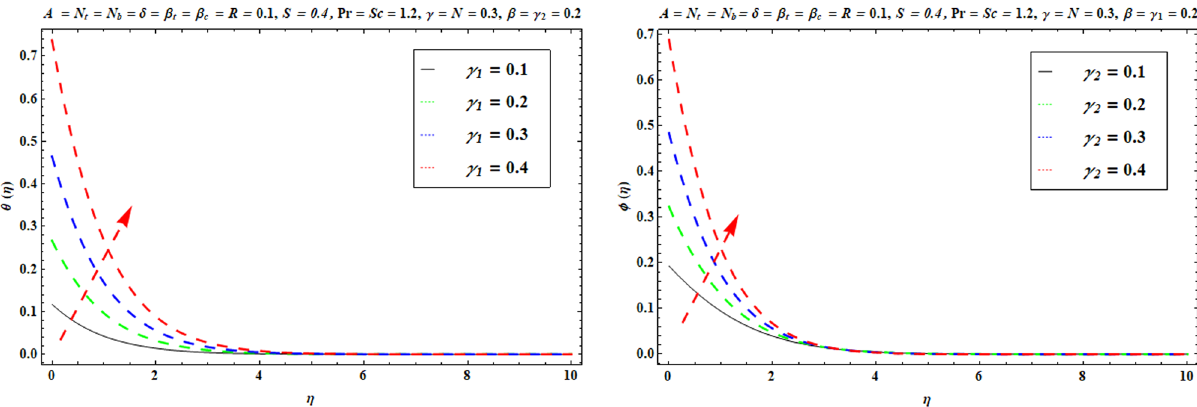
Figure 14: θ η ( ) versus γ .